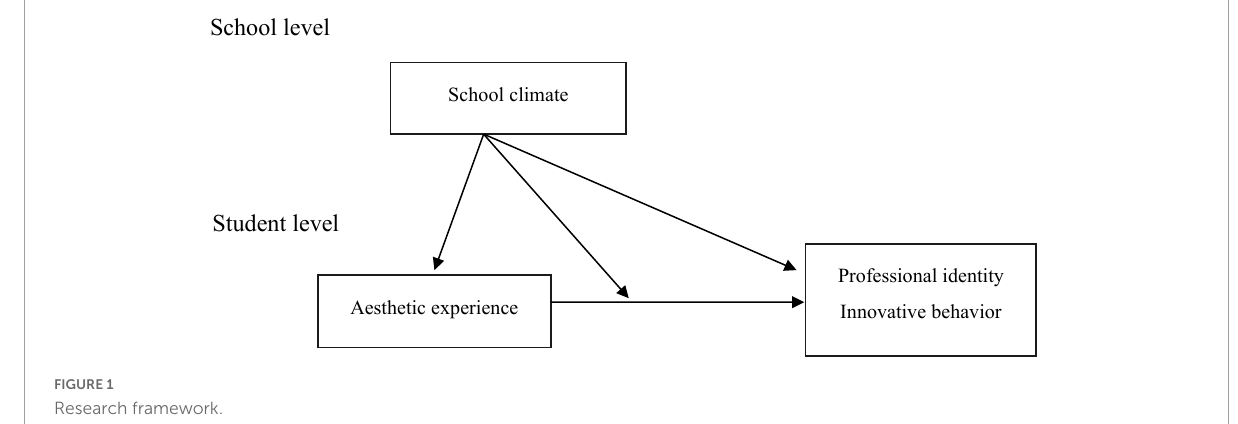
FIGURE1 Research